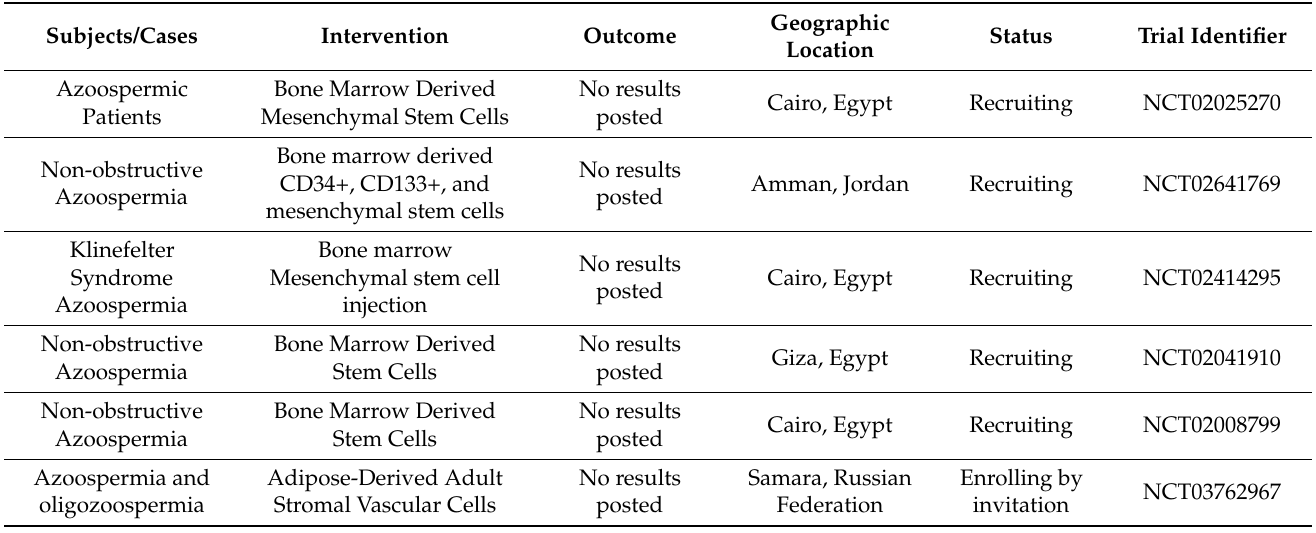
Table 2. Registered clinical trials that use stem cells for treating impaired